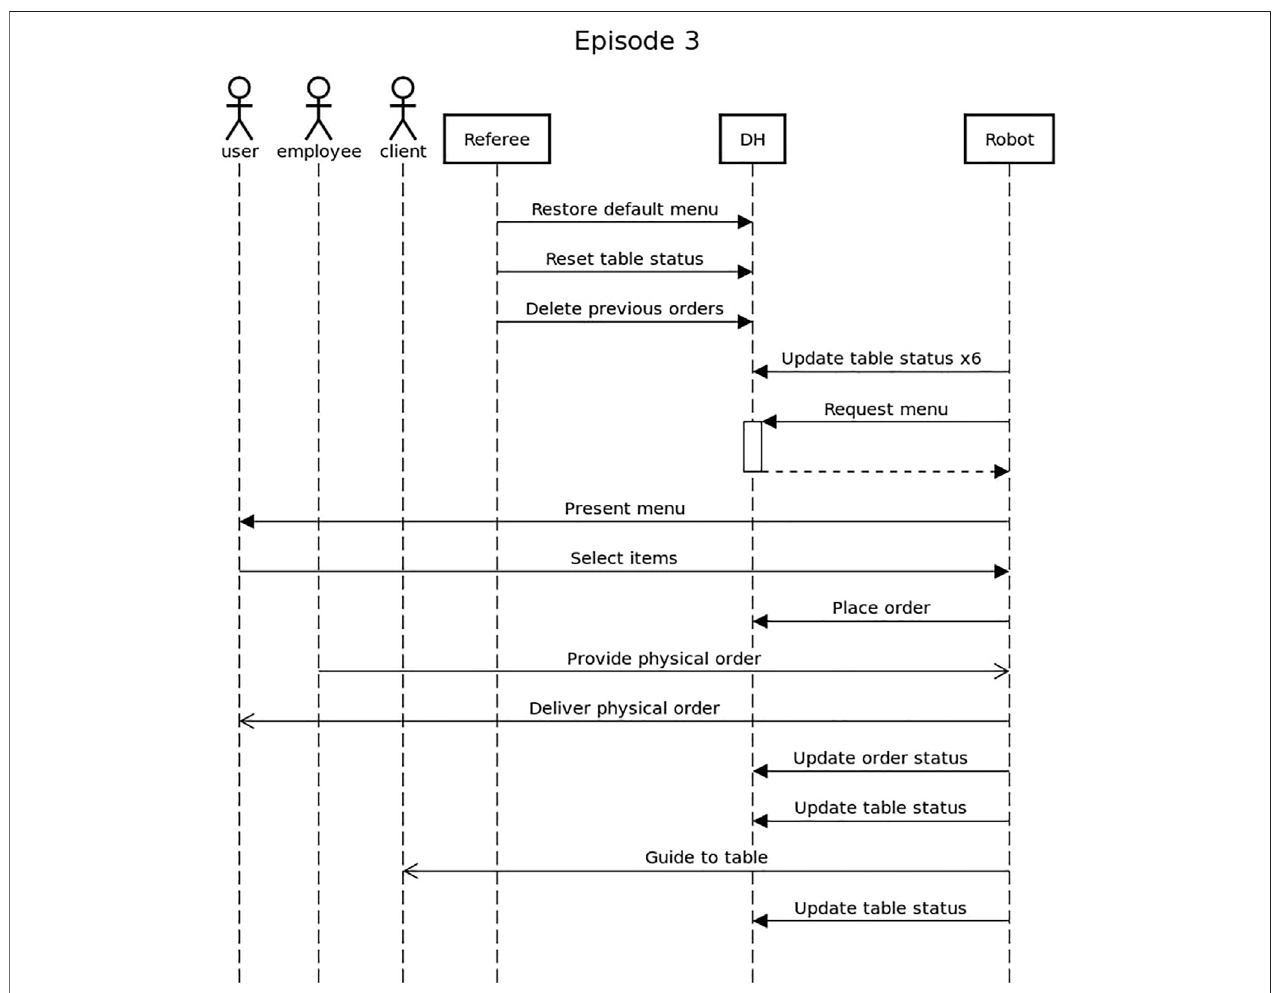
FIGURE 7 | Sequence diagram showing the interaction between the robot and the Data Hub for Episode 3